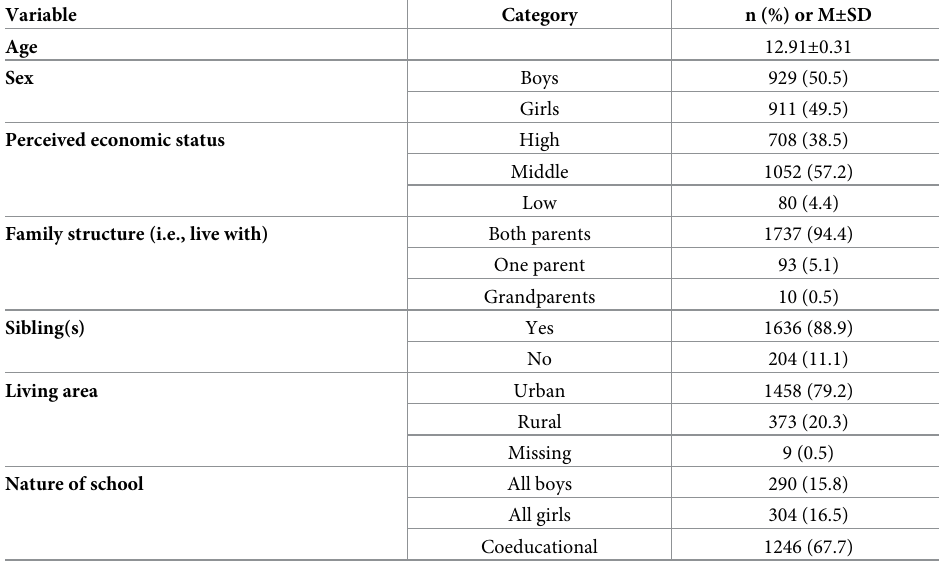
Table 1. Participants’ sociodemographic characteristics (N =